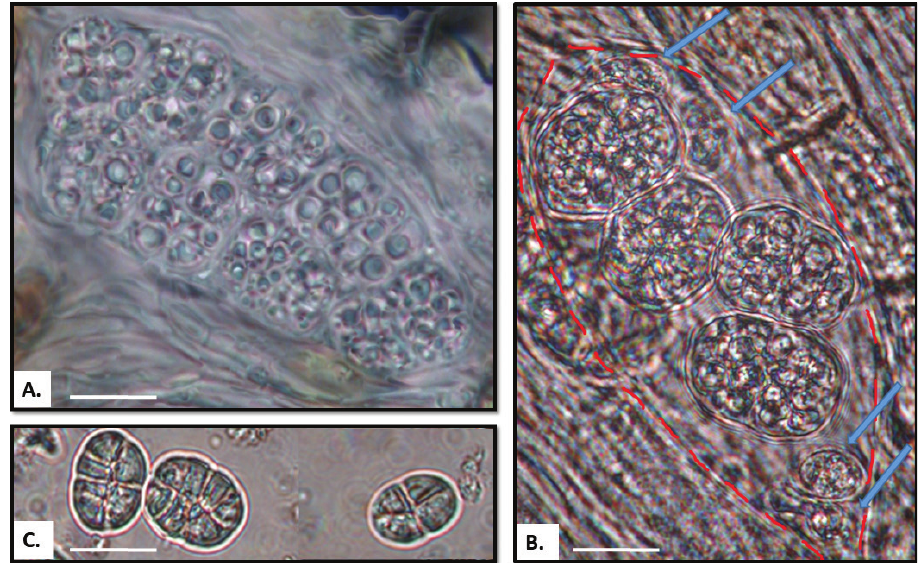
Figure 3. Ascospores: A Rostania occultata var. populina (Llop 56060303, S), cubic spores B Rostania ceranisca (Westberg L271_PL433, UPS), oblong spores; ascus (red line) with only four mature spores vis- ible but remnants of four aborted spores can be seen (arrows) C Rostania callibotrys (Sipman 2049, GZU) , oblong spores. Scale bar: 10